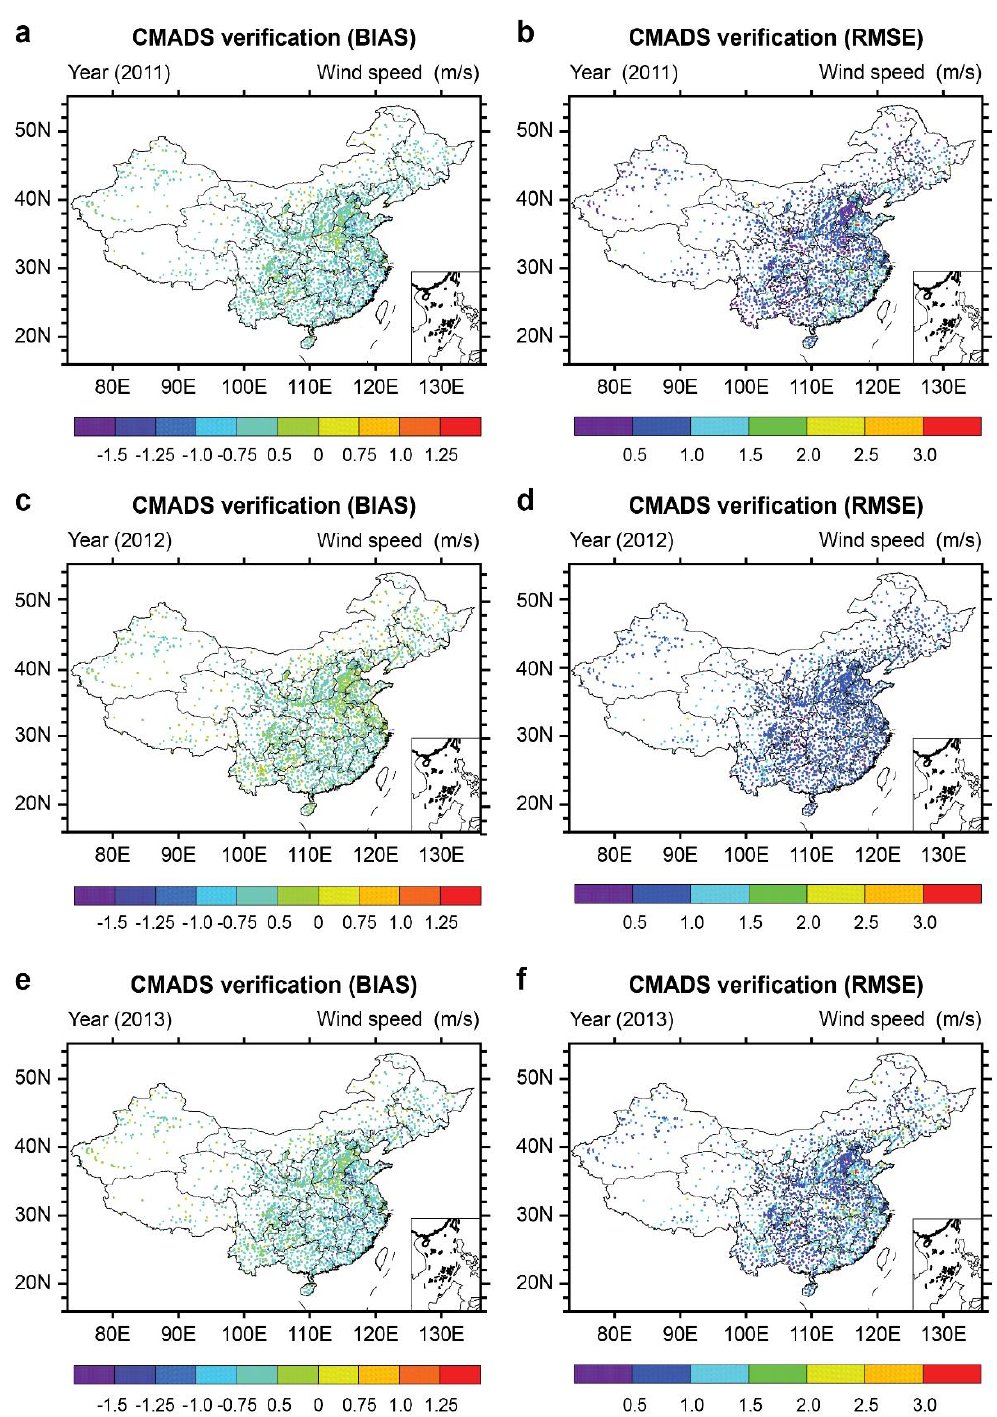
Figure 7. The evaluation of indicators for wind speed in China (2011–2013). ( a ) The spatial distributions of the biases for the wind speed in year 2011, ( b ) The spatial distributions of the RMSEs for the wind speed in year 2011, ( c ) The spatial distributions of the biases for the wind speed in year 2012, ( d ) The spatial distributions of the RMSEs for the wind speed in year 2012, ( e ) The spatial distributions of the biases for the wind speed in year 2013, ( f ) The spatial distributions of the RMSEs for the wind speed in year 2013.